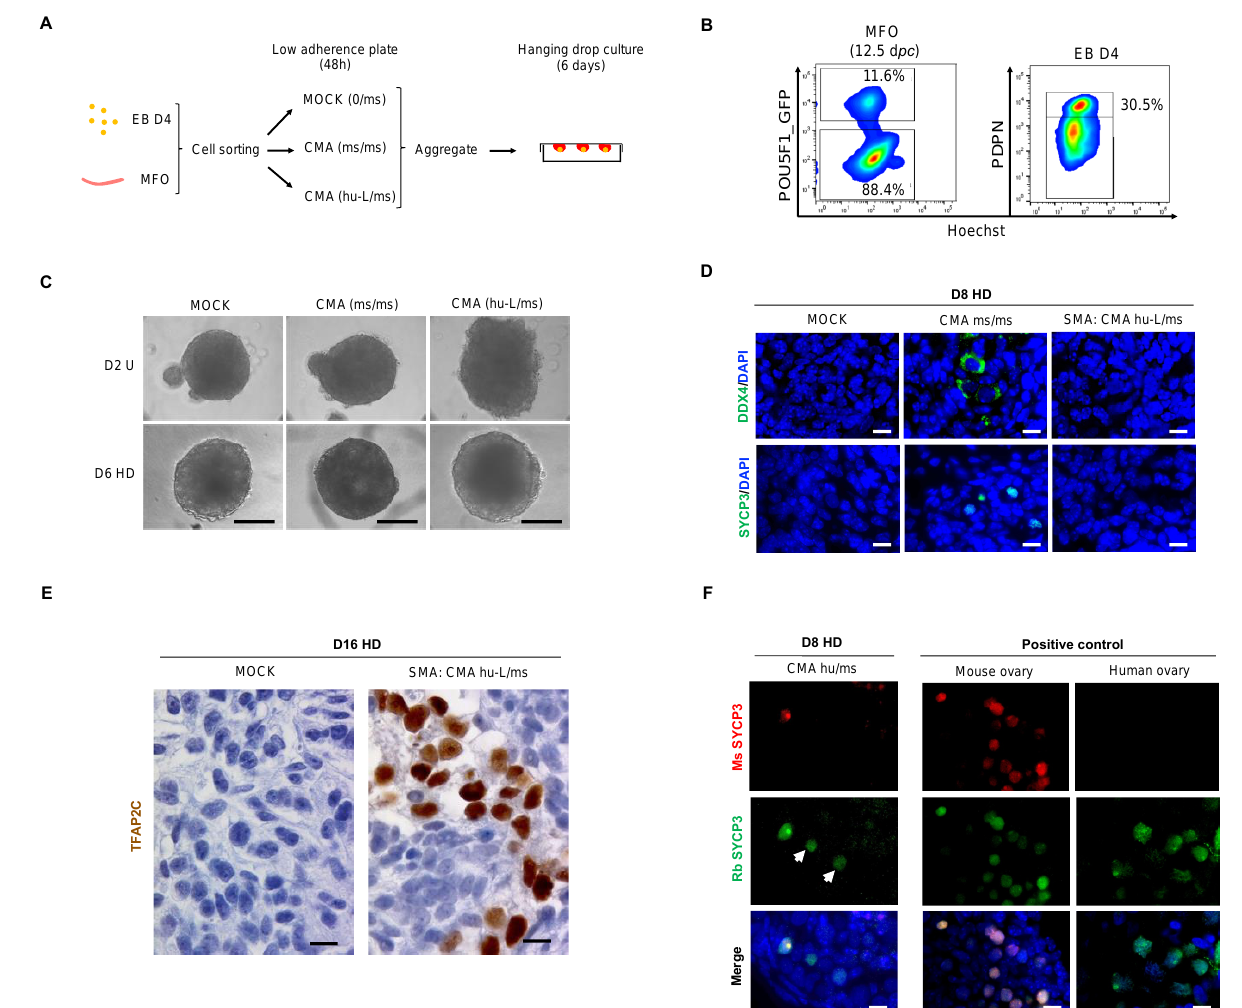
Figure 5. In vitro assessment of early hPGC-LC development when cultured in a somatic environment of murine ovary. ( A ) Schematic representation of in vitro culture procedure of re-aggregated somatic cells of murine ovary with mPGCs [CMA (ms/ms)] or hPGC-LC [CMA (hu-L/ms)] or without mPGCs/hPGC-LC [MOCK (0/ms)]. The Day 2 aggregates were transferred on a hanging drop culture system for 6 days. ( B ) Flow cytometry plots obtained after enzymatic dissociation of 12.5 dpc mouse fetal ovaries (left) and day 4 human embryoid bodies (right). Murine PGCs (POU5F1-positive) and ovarian somatic cells (OCT4-negative) were co-sorted with early PDPN-positive hPGC-LC from day 4 embryoid bodies. ( C ) Images of day 2 (top row) and day 8 (bottom row) re-aggregated ovaries in the absence (MOCK) or presence of (i) POU5F1-postive mPGCs [CMA (ms/ms)], and (ii): PDPN-positive hPGC-LC [CMA (hu-L/ms)]. Scale bar, 200 µm. ( D ) Immunofluorescence analyses for the absence or presence of DDX4 and SYCP3 proteins in MOCK, CMA (ms/ms) and CMA (hu-L/ms) conditions at day 8 of culture. ( E ) Immunofluorescence analysis for the detection of SYCP3 protein in CMA (hu/ms). Mouse and human fetal ovaries were used as positive controls for mouse and rabbit SMC3 antibodies. ( F ) Immunohistochemistry for TFAP2C protein detection in CMA hu-L/ms at day 16 of culture. Scale bar 10 µm (D, E and F). CMA hu/ms: Cell Mixture Aggregate (human PGC/Mouse somatic cells); CMA hu-L/ms: Cell Mixture Aggregate (human PGC-Like Cells/Mouse somatic cells); CMA ms/ms: Cell Mixture Aggregate (Mouse PGC/Mouse somatic cells); D8 HD: Day 6 from Hanging Drop; D16 HD: Day 14 from Hanging Drop; D2 U: Day 2 from U-bottom low adherence 96 well plate; d pc : day post-coïtum ; EB D4: Embryoid Body at Day 4; MFO: Mouse Fetal Ovary; MOCK (0/ms): 12.5 d pc mouse ovarian somatic cells only.